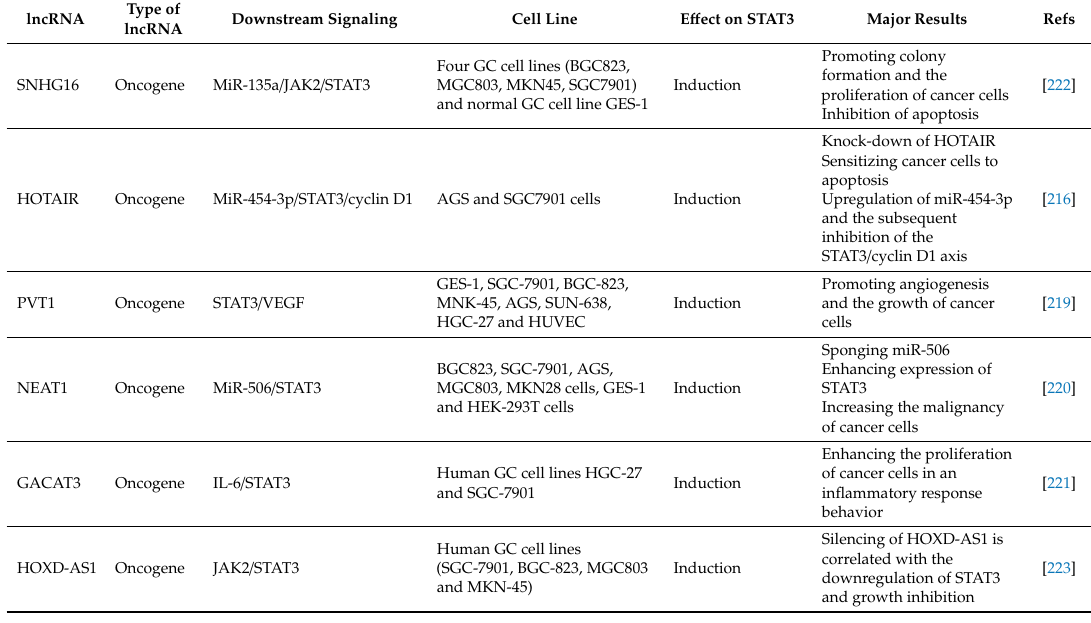
Figure 4. Long non-coding RNAs and their downstream targets in the regulation of the STAT3 signaling pathway in GC cells. Table 5. lncRNAs as upstream modulators of STAT3 signaling pathway in GC cells.